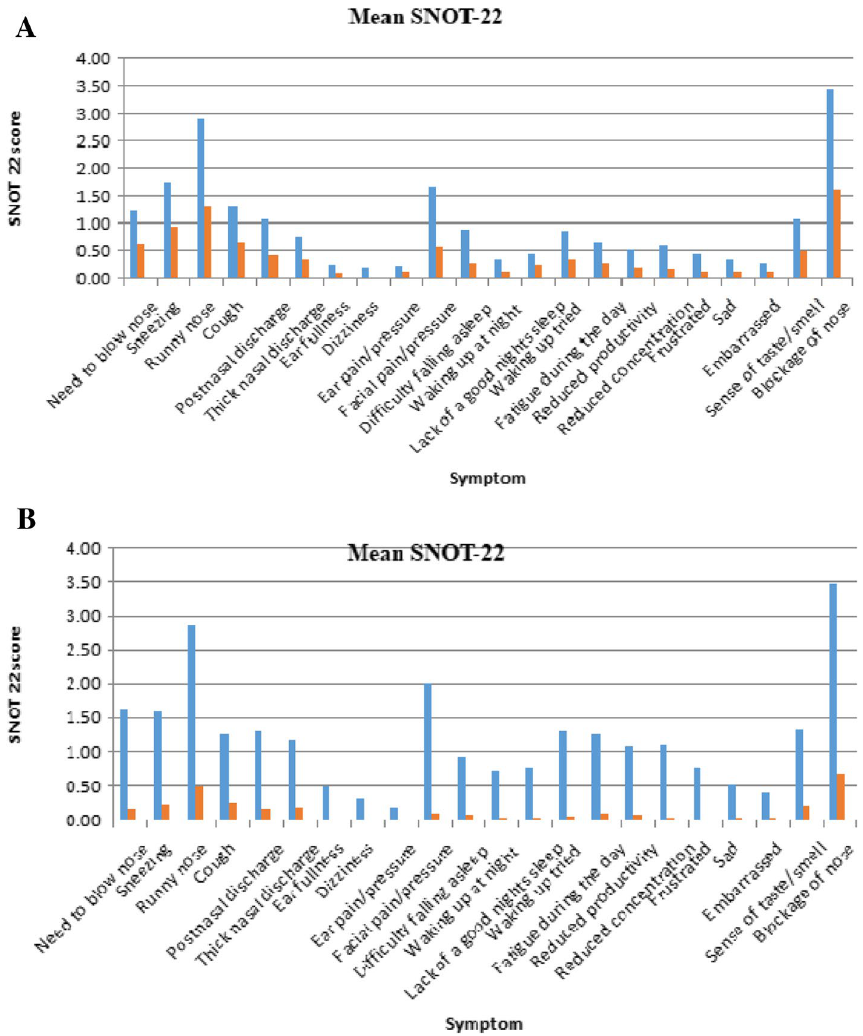
Fig. 2 Mean score of individual symptoms from SNOT-22 score in both groups. Blue color represents before treatment score, and orange color represents after treatment score. A Comparison of before and after treatment individual mean SNOT-22 score in group A patients. B Comparison of before and after treatment individual mean SNOT-22 score in group B patients. The mean score of all the symptoms was reduced in both groups